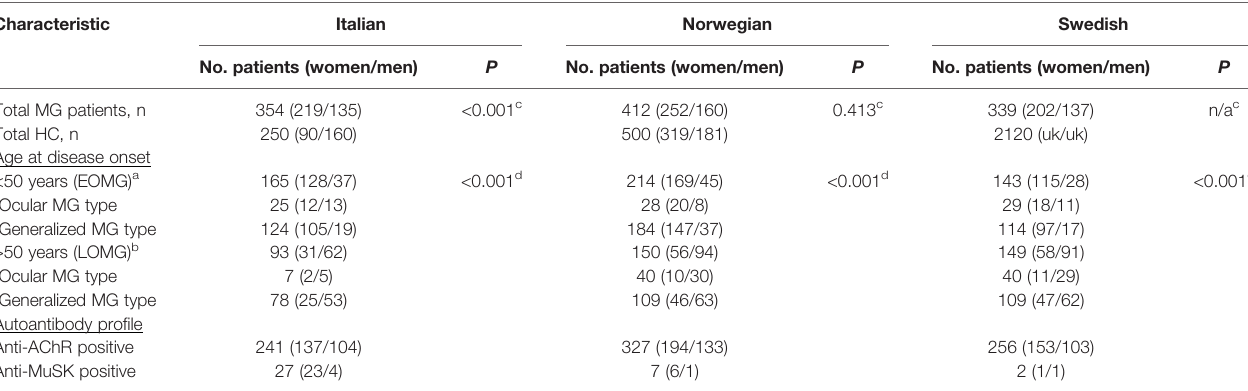
TABLE 1 | Characteristics of myasthenia gravis patient